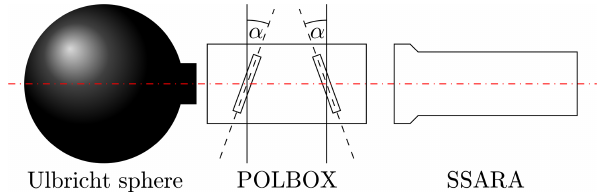
Figure 3. Polarimetric calibration setup. The distance between the Ulbricht sphere and the POLBOX, and between the POLBOX and the SSARA sensor head are on the order of a few centimeters along the optical axis (shown as a dashed red line). The glass plate angle α of the POLBOX can be adjusted between 0 and 65 ◦ . Additionally, it can be rotated through 360 ◦ around the optical axis by the angle ϑ